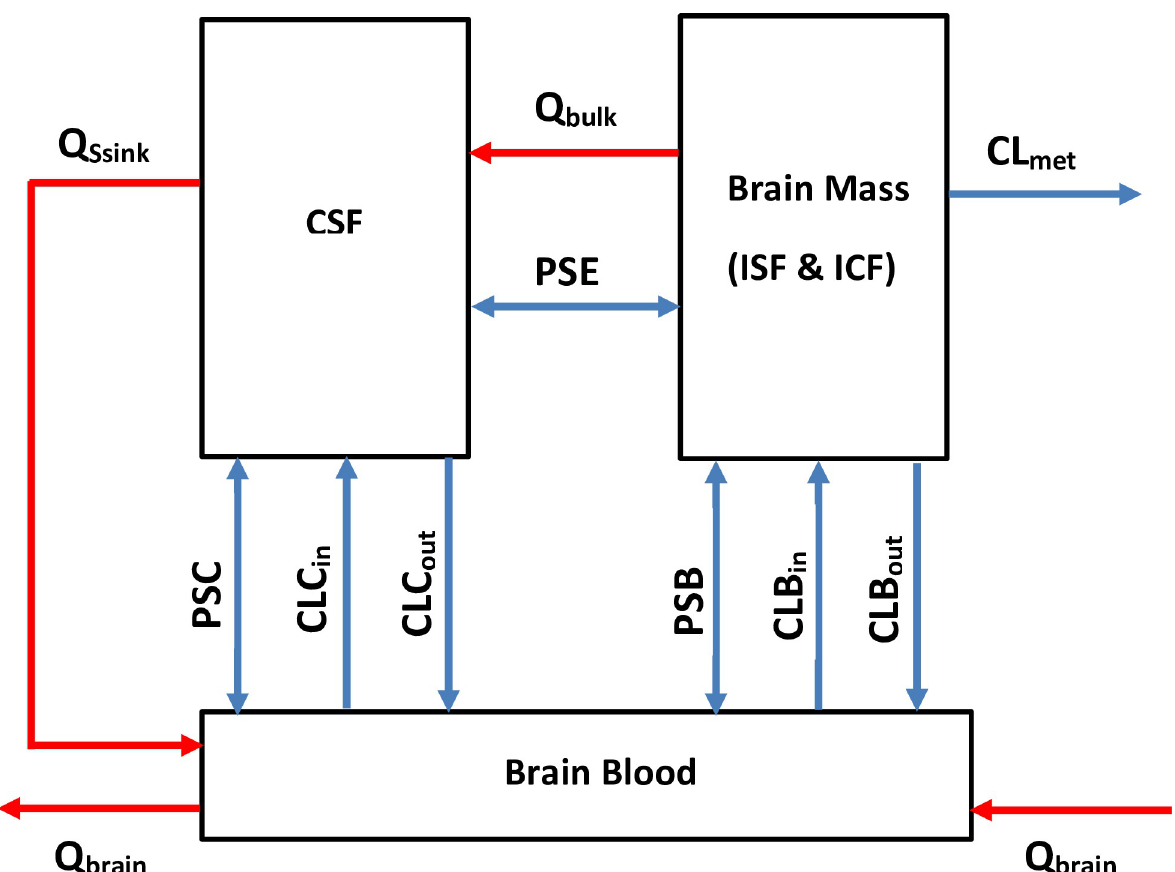
Fig 1. Multi-compartment brain model in rodents as defined in Simcyp Animal Simulator V17. The structure of the multi-compartment brain model in rodents includes three compartments viz., the brain blood, brain mass and the CSF. Qbulk and QSsink represent the bulk flow from the brain mass to the CSF compartment and the CSF flow out of the CSF into the brain blood compartment, respectively while Qbrain is the cerebral blood flow through which the multi-compartment brain model is connected to the whole body. CLBin, CLBout, CLCin and CLCout are the overall clearance of uptake and efflux transporters expressed at BBB and BCSFB respectively and CLmet (L/h) is the metabolic clearance due to brain enzymes. PSB, PSC and PSE denote the passive permeability- surface area products on the BBB, BCSFB and CSFBB, correspondingly.